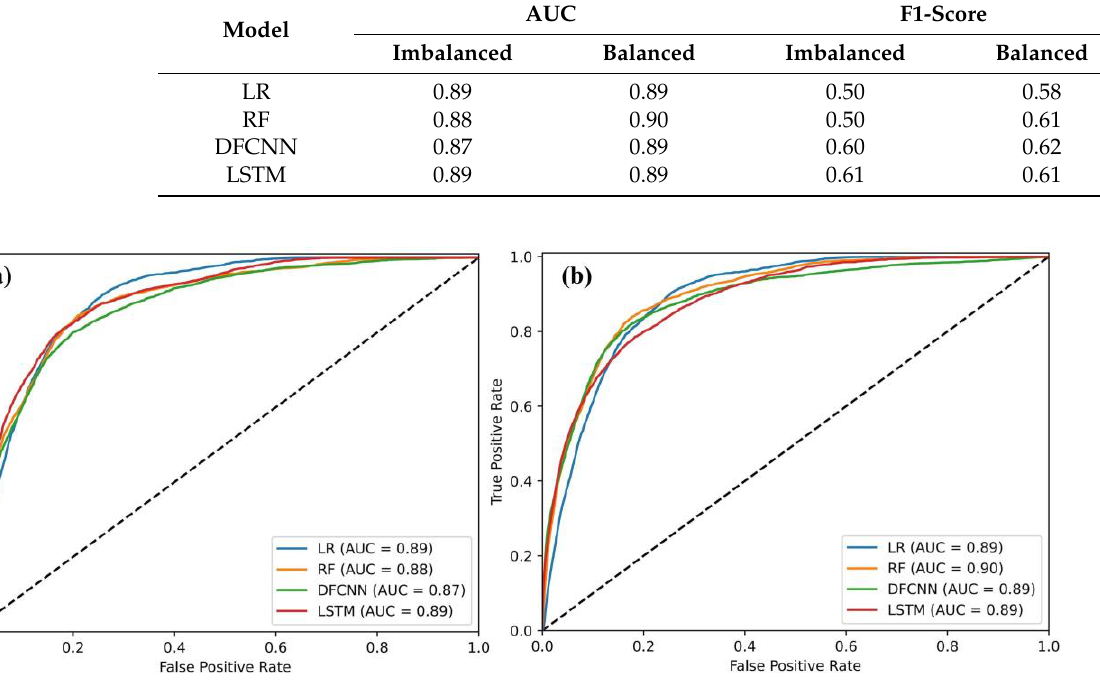
Figure 11. ROC curves of four models: ( a ) ROC curves under class imbalanced strategy, ( b ) ROC curves under class balanced strategy. Table 3. Performances of four models under the imbalanced strategy and balanced strategy.